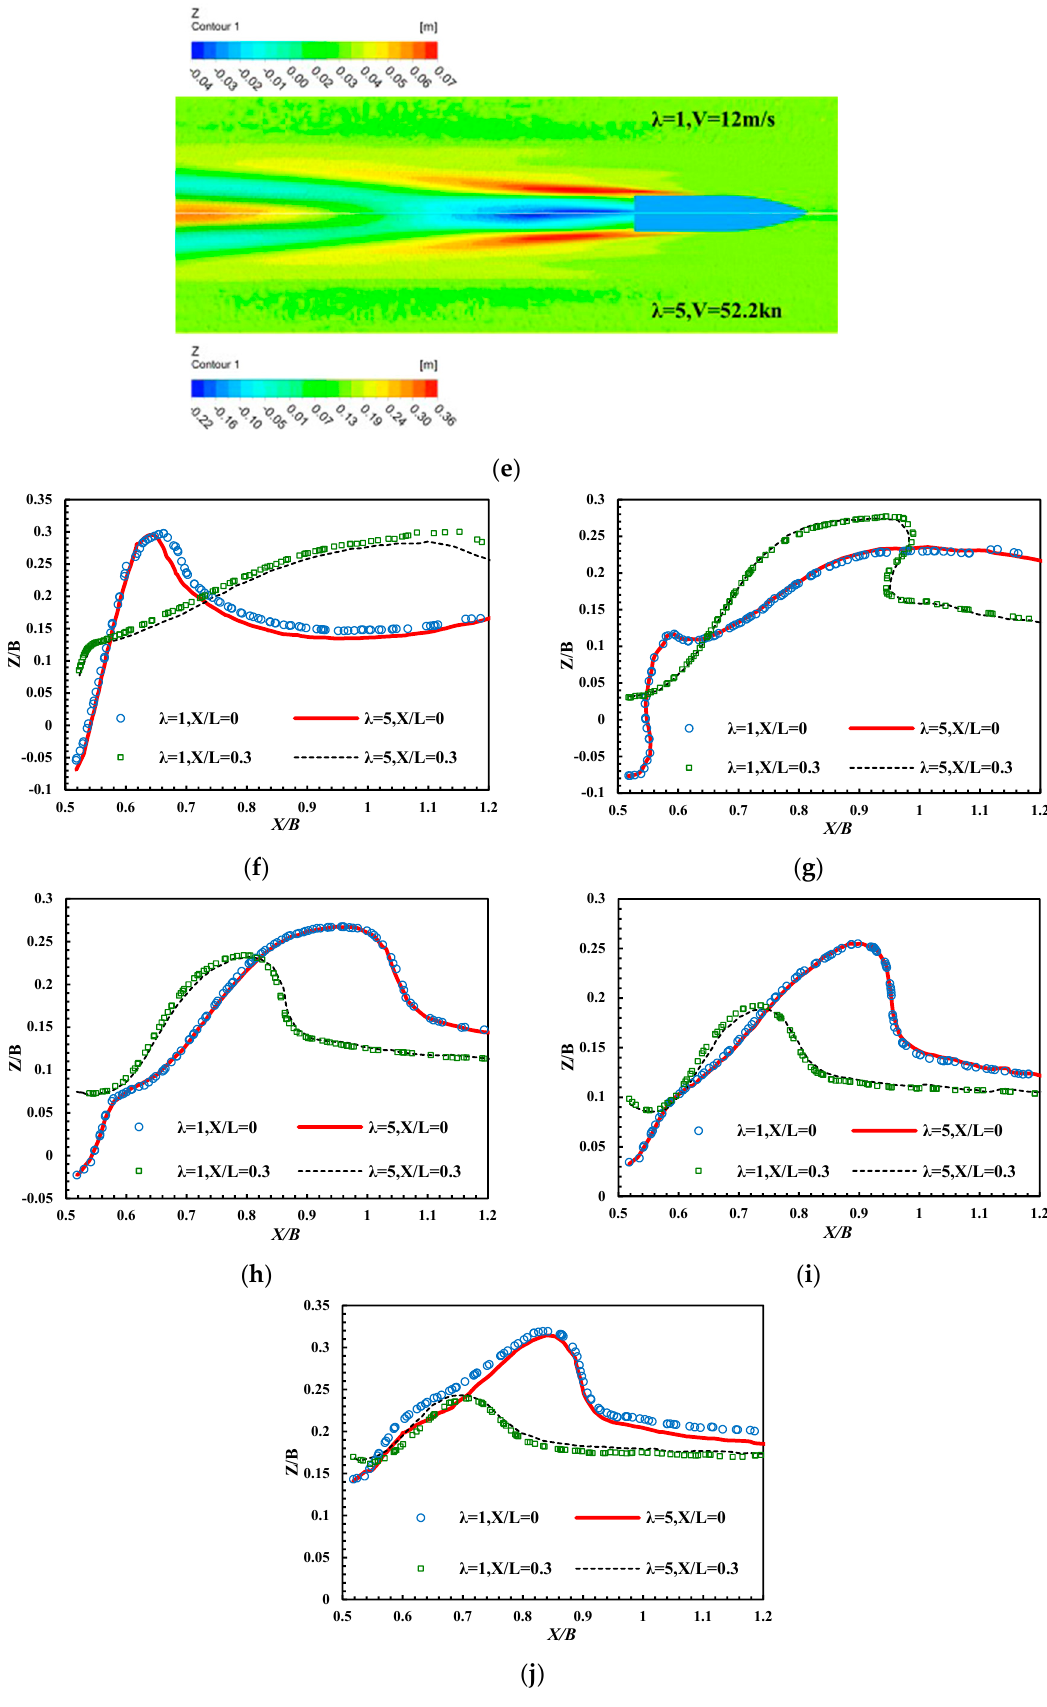
Figure 12. The Flow and the transverse wave pattern of stepped planing hull in both model and full-scaled boat: ( a , f ) Fr ∇ = 2.29; ( b , g ) Fr ∇ = 3.34; ( c , h ) Fr ∇ = 4.58; ( d , h ) Fr ∇ = 5.73; ( e , j ) Fr ∇ =